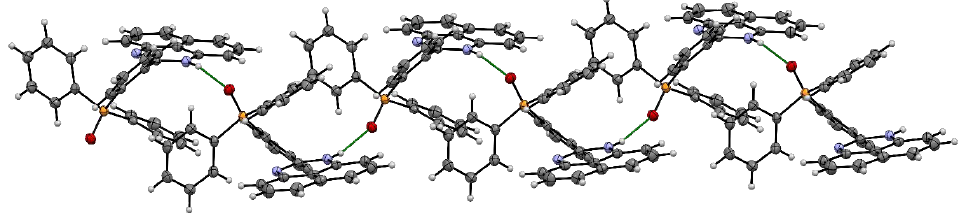
Figure 3. A hydrogen-bonded structure of L1 formed via N-H · · · · ·O bonds. Atom colours: (a) blue = nitrogen, (b) white = hydrogen, (c) red = oxygen, (d) orange = phosphorus, (e) grey = carbon.